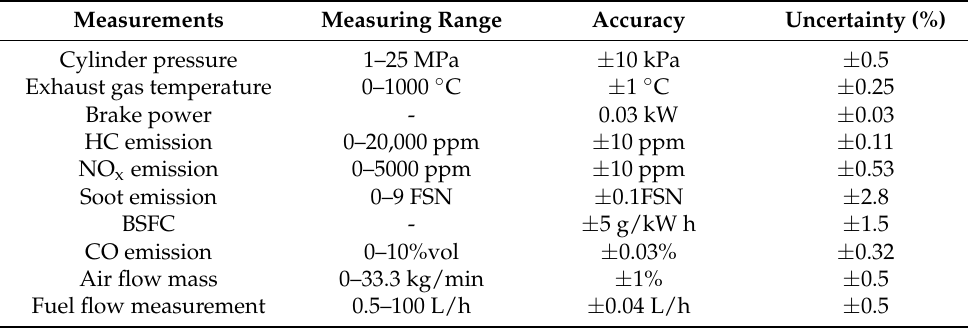
Table 3. Lists of measurements, the measuring range, and accuracy.